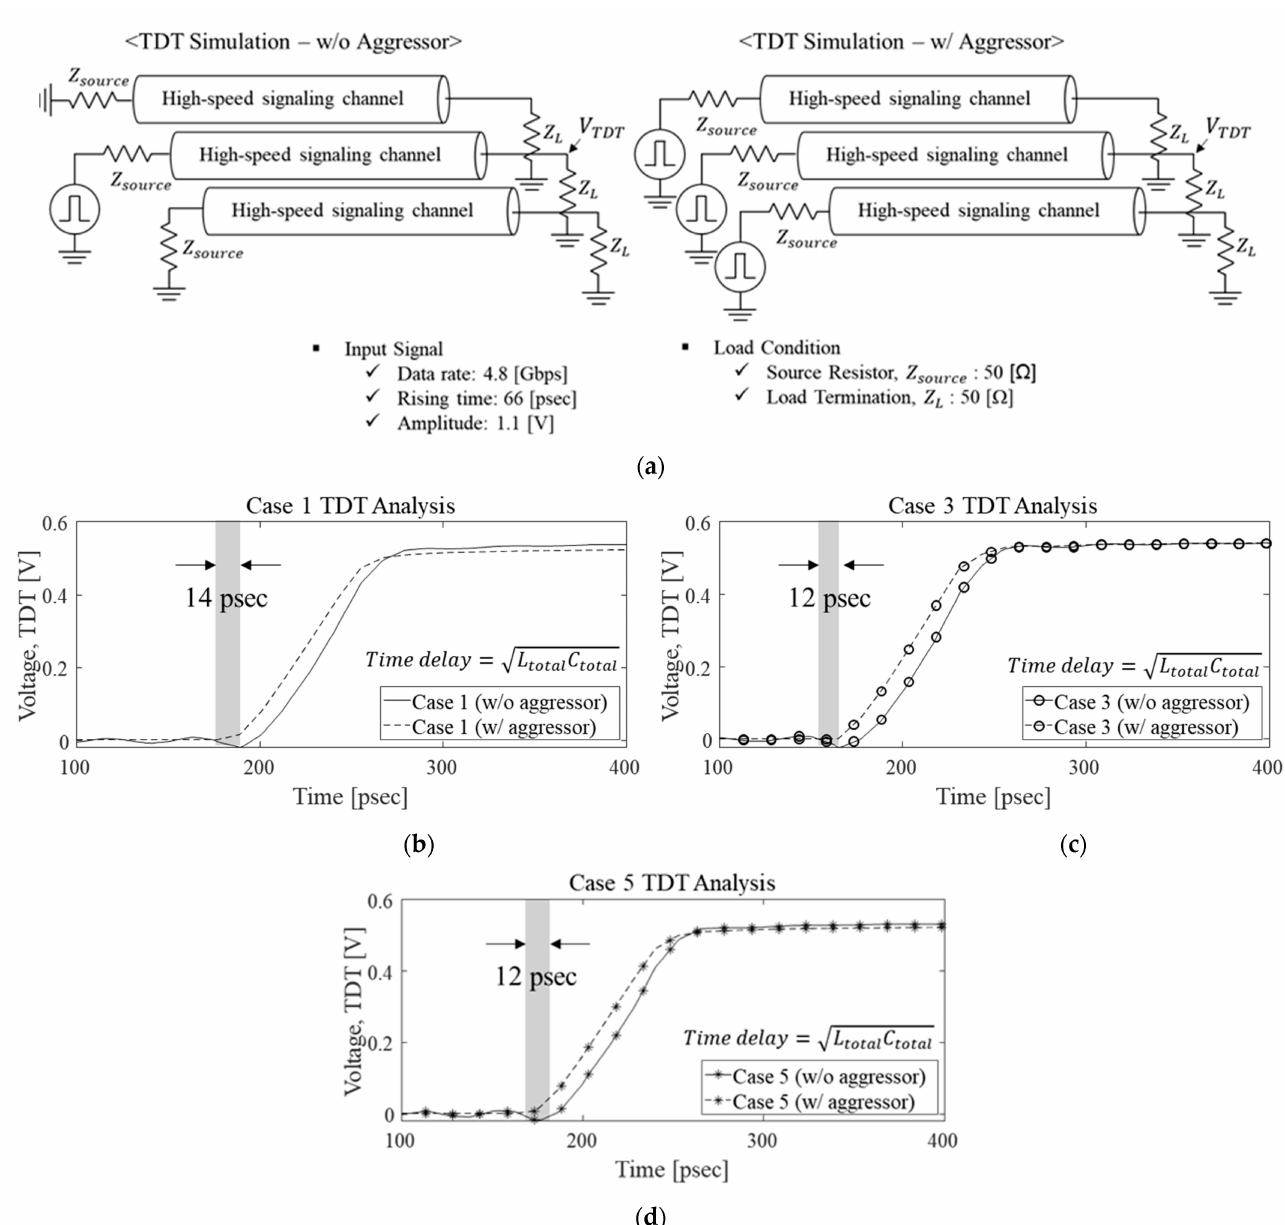
Figure 13. ( a ) Time domain simulation set-up for three coupled channels. To evaluate the effect of two aggressor channels in the time domain, the simulation parameters, including the rising time and amplitude suitable for the 4.8 Gbps target, were set. Using this set-up, the effect of the two aggressor channels is shown for ( b ) case 1, ( c ) case 3, and ( d ) case 5 with and without an aggressor